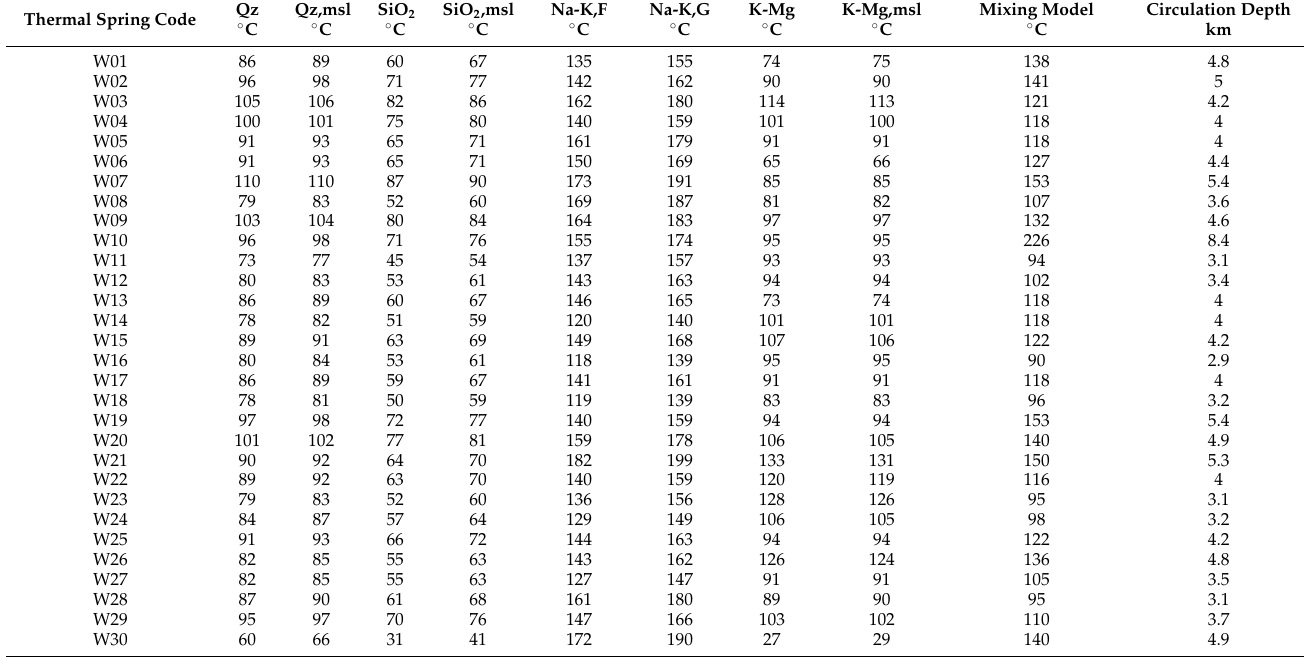
Table 2. Apparent equilibrium temperatures computed through multi-geothermometers for the samples collected from the thermal springs of